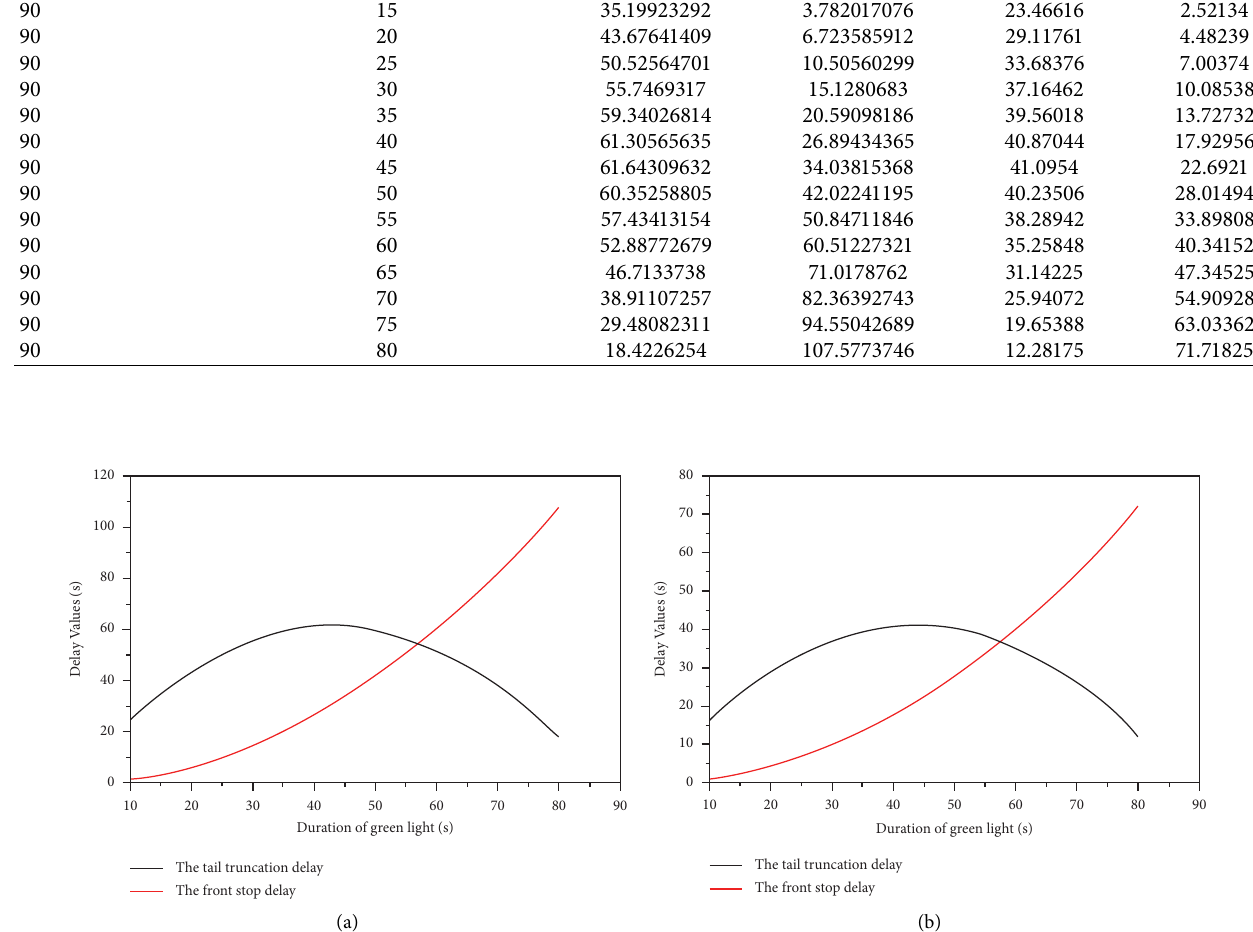
Figure 4: Line graphs of the front vehicles of discrete traffic flows were stopped and the tail vehicles of discrete traffic flows were